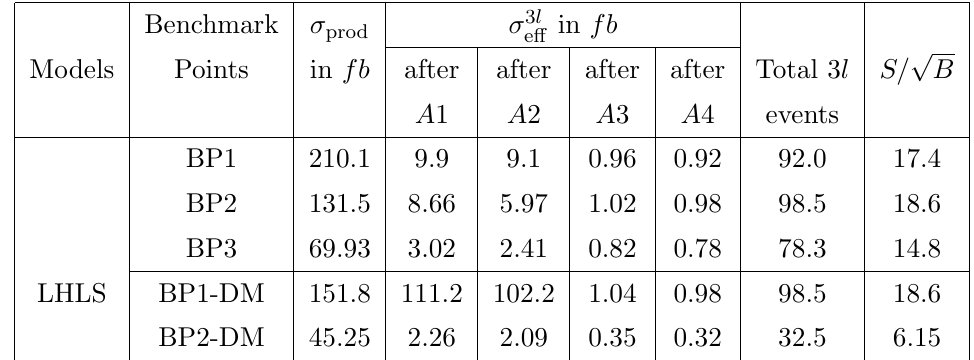
Table 10 . The production cross-sections of all EWeakino pairs and (cid:27) 3 l table 5 and table 7. Also the total number of 3 l events along with S= luminosity of 100 fb (cid:0) 1